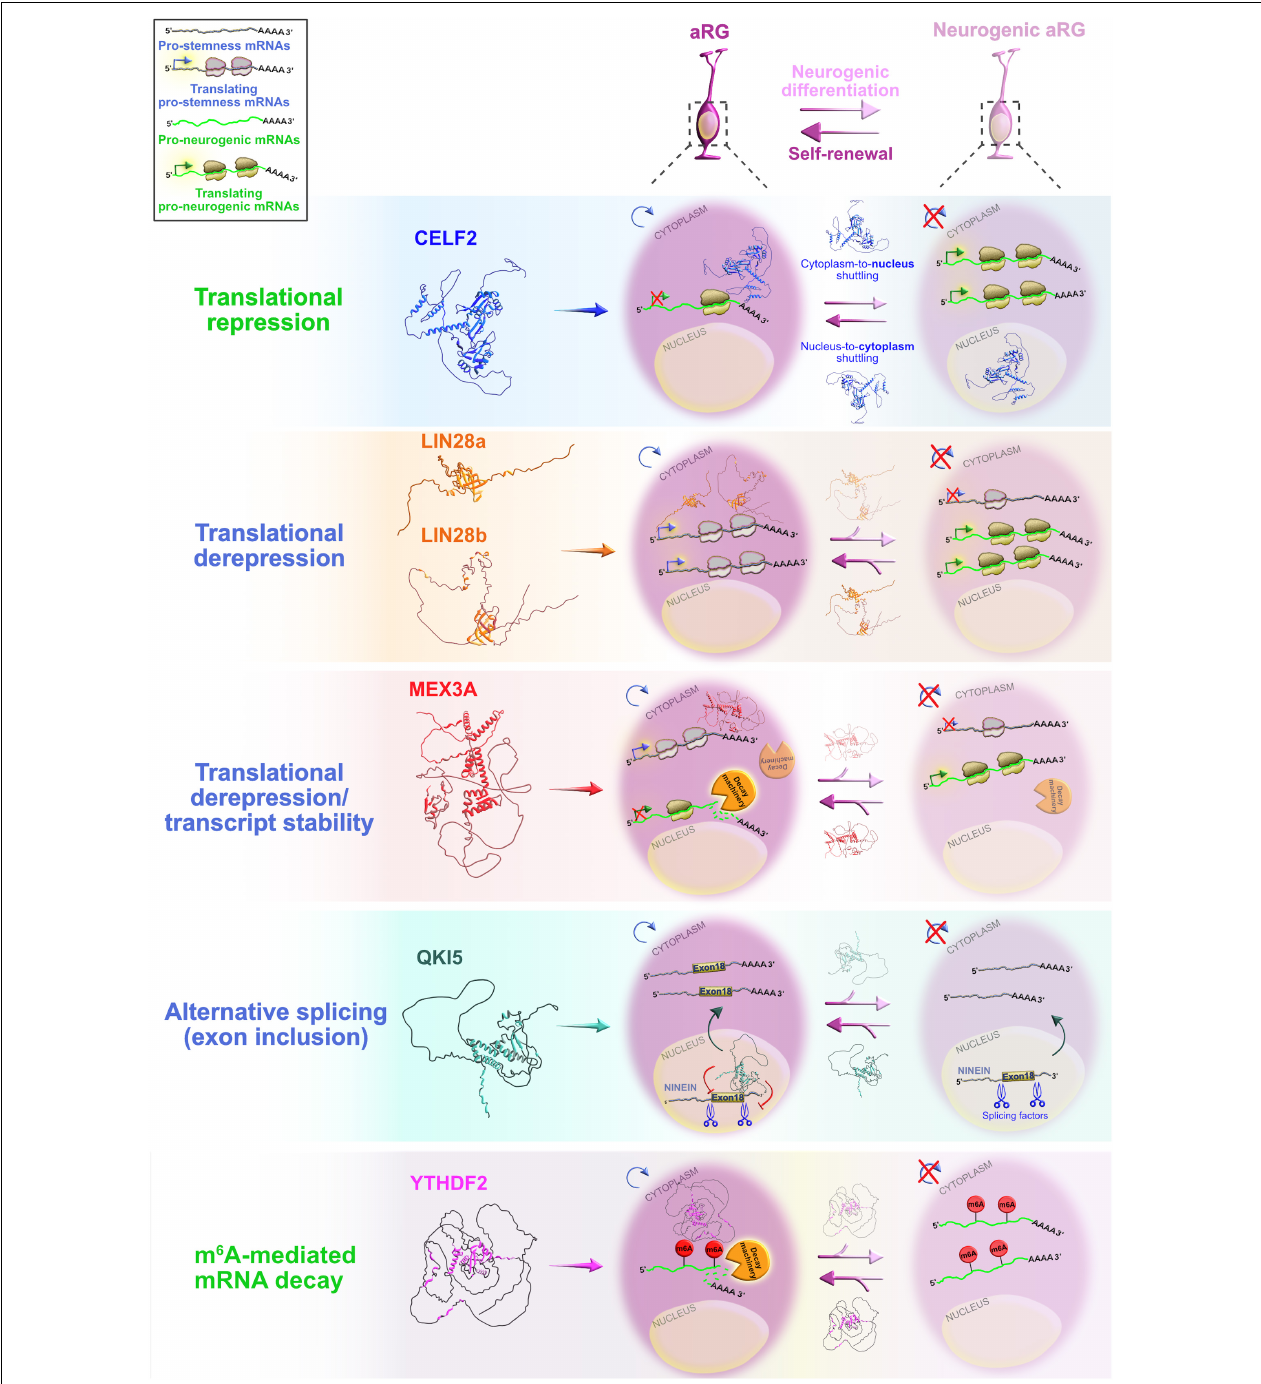
FIGURE 4 | Post-transcriptional regulation by RNA-binding proteins (RBPs) and transcriptional priming in apical radial glia (aRG). Summary of the functional roles of RBPs CELF2, LIN28a/b, MEX3A, QKI5, and YTHDF2 in determining the fate of aRG, which are transcriptionally primed to differentiate into neurons. Cytoplasmic CELF2 maintains aRGs in the undifferentiated state by translationally repressing pro-neurogenic mRNAs. LIN28a/b achieves the same outcome by promoting the expression of pro-self-renewal transcripts. The regulatory mechanism by which MEX3A contributes to aRG maintenance and controls the appropriate time of aRG differentiation is unclear; MEX3A may either act as a translational repressor/derepressor of pro-neurogenic/pro-stemness mRNAs, or it can promote transcript stability/decay. The nuclear isoform of QKI (QKI5) controls the aRG-to-neuron transition via pre-mRNA alternative splicing (e.g., inclusion of exon 18 into Ninein pre-mRNA protects aRG proliferative capacity). YTHDF2 promotes N 6 -methyladenosine (m 6 A)-mediated decay of pro-neurogenic transcripts, acting as a pivotal regulator of self-renewal capabilities of aRG. The predicted tertiary and secondary full-length protein structures of RBPs in Homo sapiens are adopted from https://www.uniprot.org: CELF2 (O95319), LIN28a (Q9H9Z2), LIN28b (Q6ZN17), MEX3A (A1L020), QKI (Q96PU8), and YTHDF2 (Q9Y5A9).